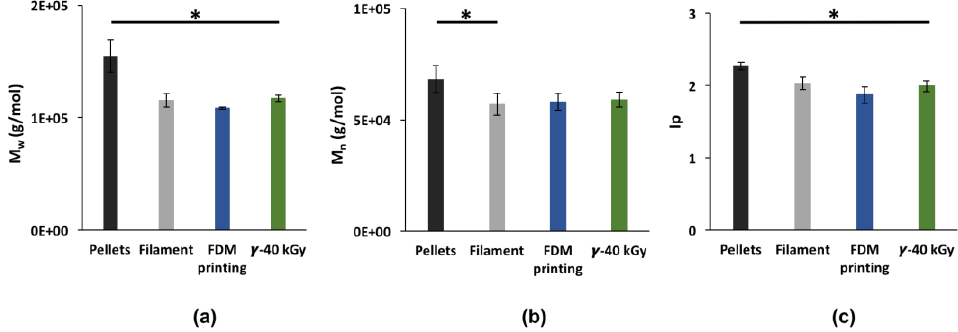
Figure 2. Impact of the manufacturing process on Mw ( a ); Mn ( b ); and Ip ( c ). Data are expressed as